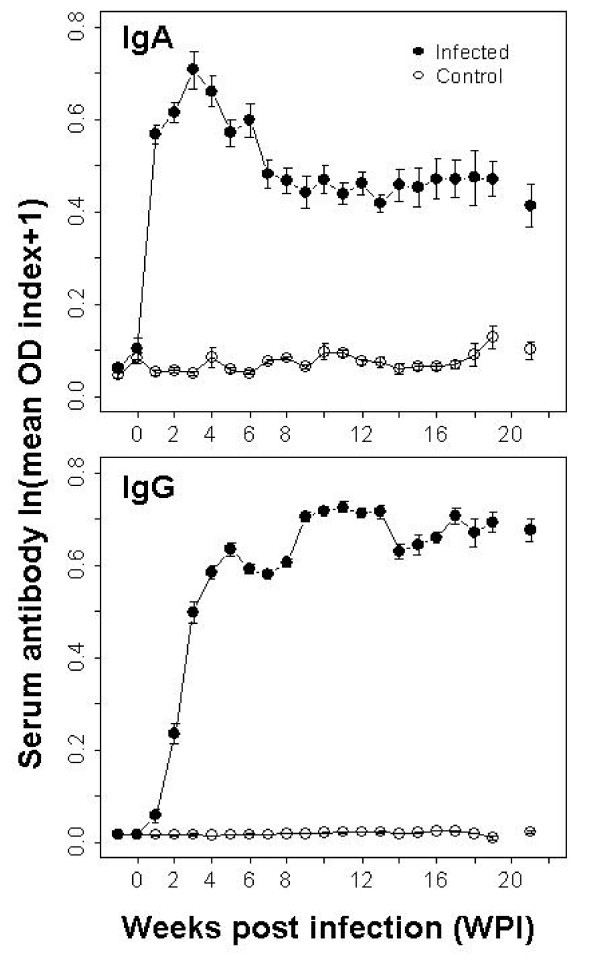
Mean serum antibody response (OD index ± S.E.) in infected and control rabbits by sampling week (WPI). Serum was collected twice from all individuals prior to infection (48 rabbits sampled at week -1) and weekly thereafter. Number of samples decreased with time of infection as groups of 6 individuals (4 infected and 2 controls) were regularly sacrificed. Sera were assayed individually.